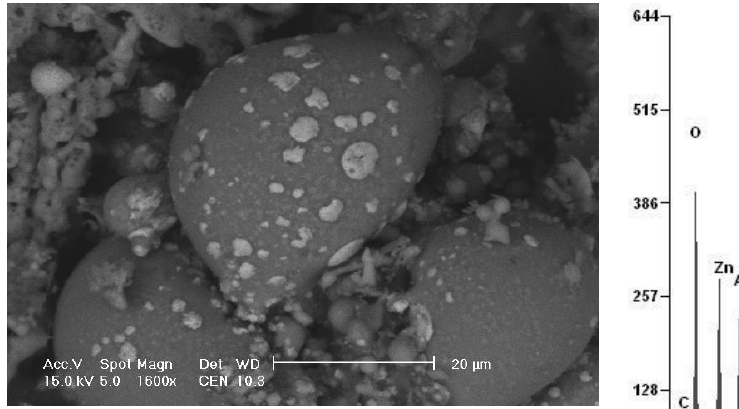
Fig. 1. SEM image and EDS spectrum of aluminosilicate particle in ash from hard coal combustion in individual household